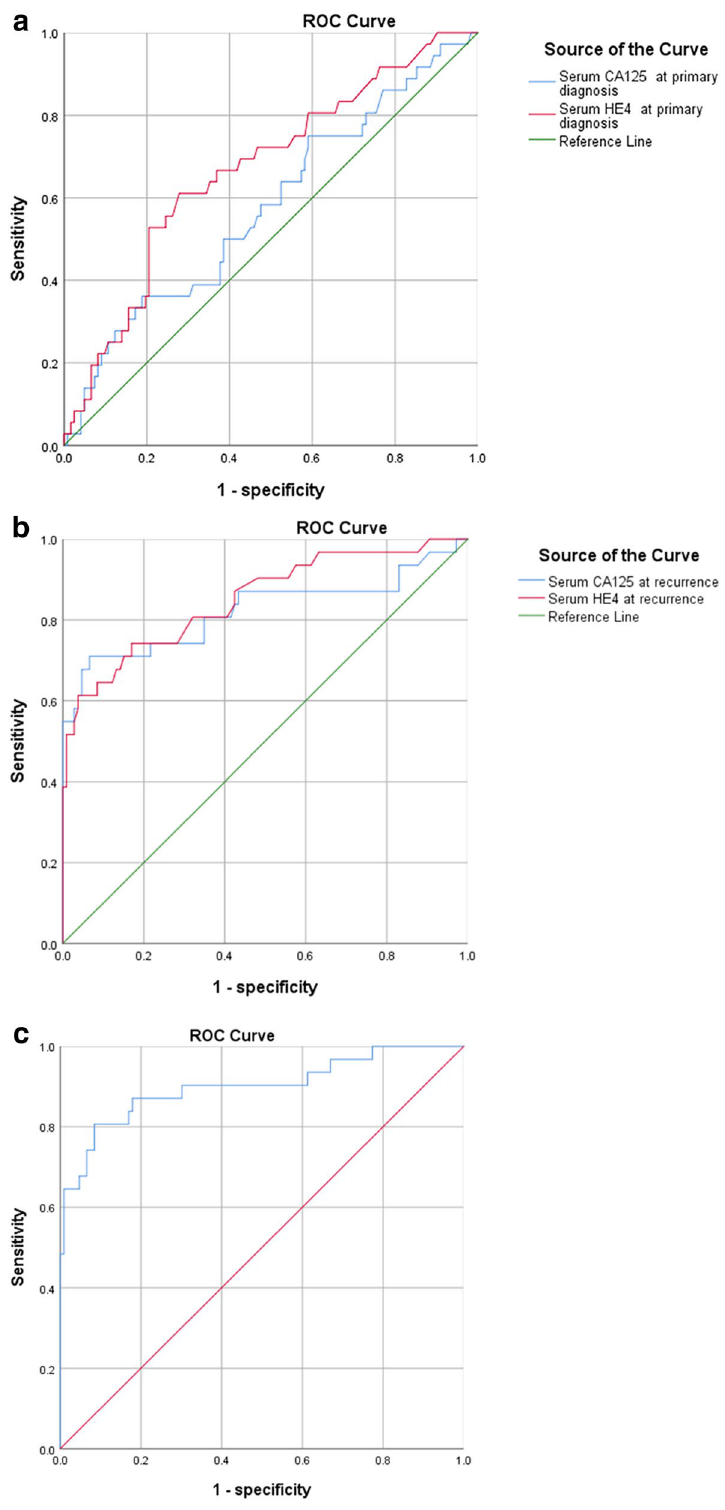
Figure 1. The ROC curve of serum CA125 and HE4 at primary diagnosis ( a ), CA125 and HE4 at recurrence ( b ), the combination of CA125 and HE4 at recurrence ( c